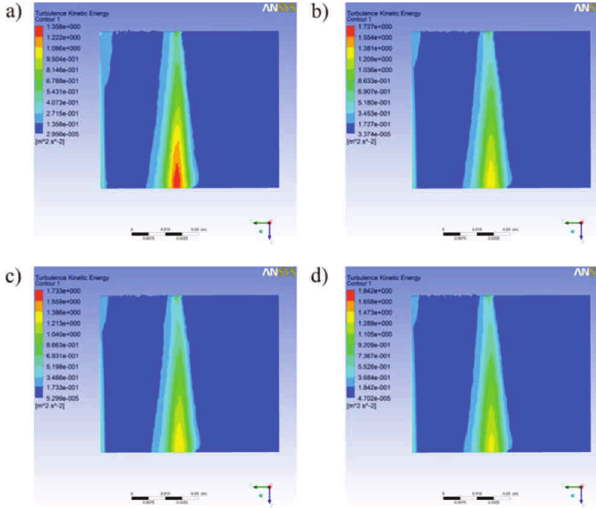
Fig. 9. The distribution of TKE inside of cylinder by the twisting angle ( θ ) for w = 8 m/s: a) q = 6 deg, b) q = 12 deg, c) q = 18 deg, d) q = 24 deg When the tape-twisting angle increased, the gradient of the turbulent kinetic energy decreased. Similar relations were observed for the other analysed initial air-flux flow velocities. The smaller TKE gradients confirm that the flexible element strongly affect the charge motion and their flow through the inlet system to the cylinder. In addition, the dynamic forces of molecular interaction of the swirling air flux decay the trend of the air flow to become a turbu- lent. Fig. 8. Location of the planes for numerical analysis: 1 – the cylinder axis plane, 2 – the cylinder cross-section plane, 3 – cylinder wall, 4 – inlet canal, 5 – flexible tape